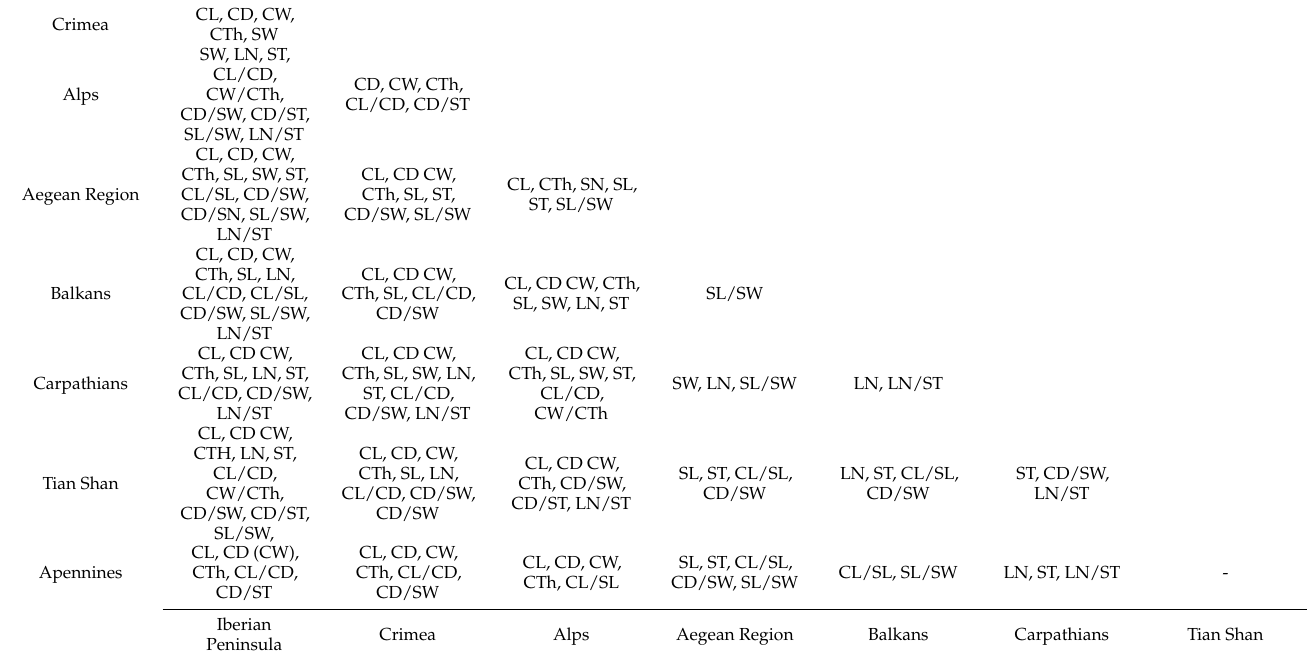
Table 4. Characteristics differing significantly geographical regions of J. sabina (Table 1) according to results of Kruskal-Wallis’ test, character’s codes as in Table